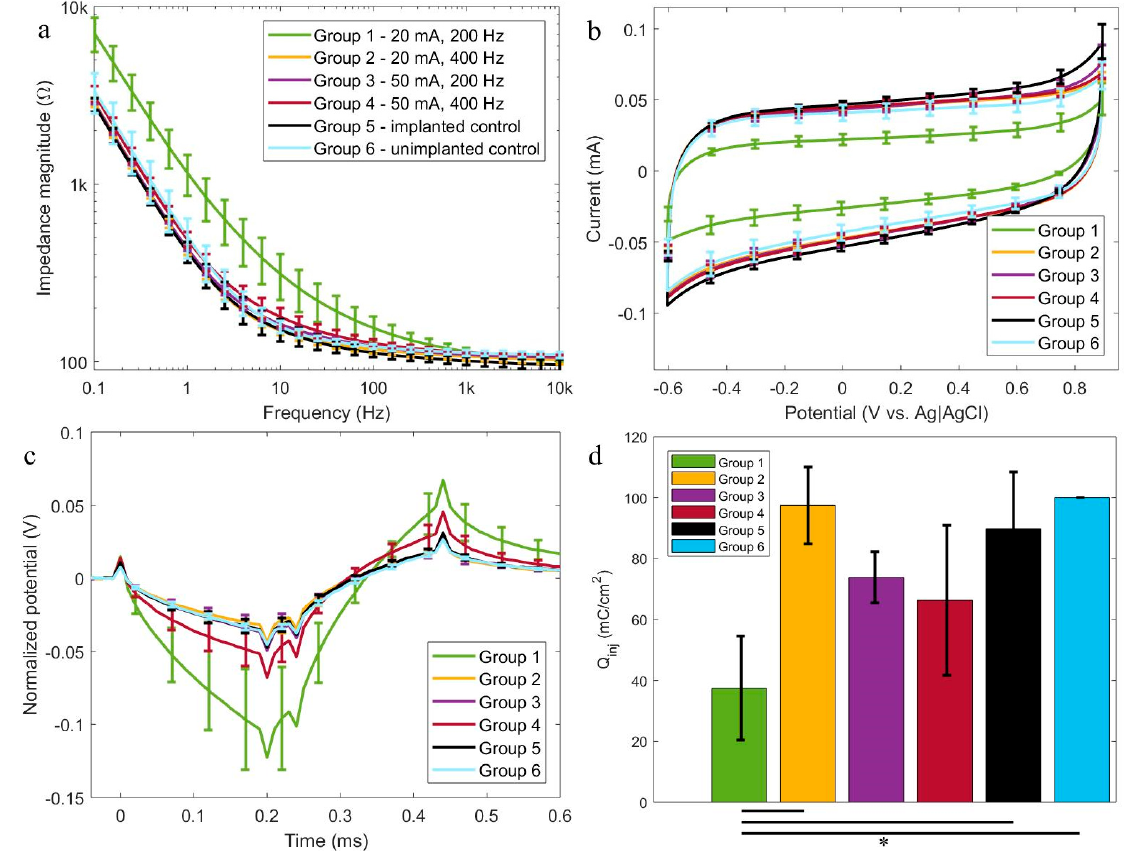
Figure 6. ( a ) The impedance magnitude was significantly larger for electrode group 1 compared to the other electrode groups, which was implanted and pulsed at the lowest electrical dose. ( b ) The cyclic voltammogram shows that the charge storage capacity of electrode group 1 was significantly smaller than the other electrode groups. ( c ) The normalized voltage transients at 5 mA show that the slope of the group 1 electrodes was larger than the slopes of the other electrode groups but no significant difference was found for C pulse . ( d ) Q inj of group 1 electrodes was significantly smaller than Q inj of group 2, 5 and 6 electrodes.